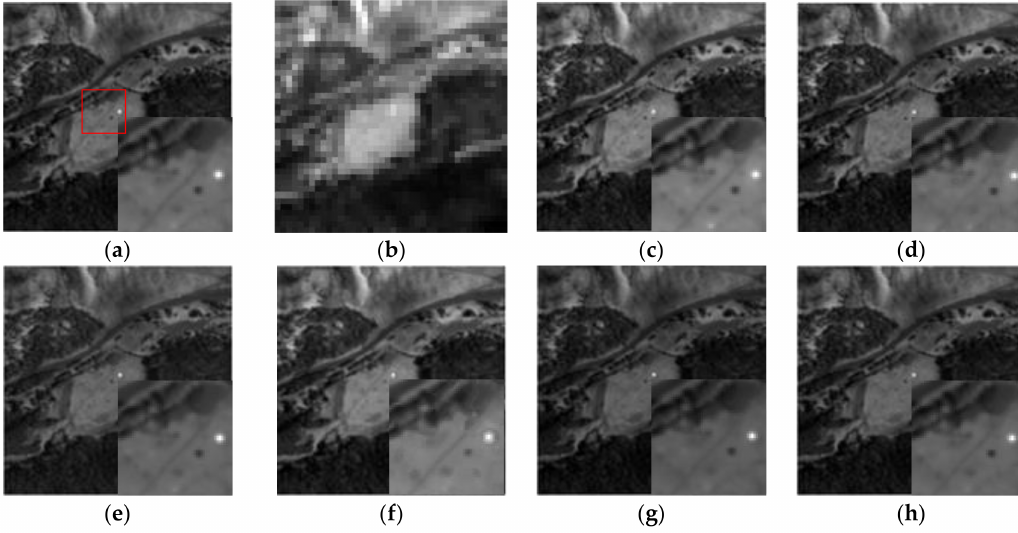
Figure 12. Details of original and resolution enhanced Montana HSS images at wavelength of 1190 nm: ( a ) reference; ( b ) input; ( c ) MAP; ( d ) CNMF; ( e ) Bayesian; ( f ) NSSR; ( g ) LASUF; ( h )